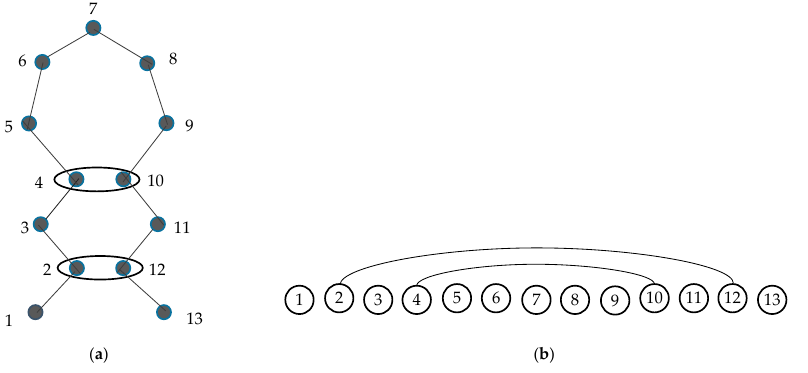
Figure 1. ( a ) Schematic diagram of a protein backbone. Amino acid 2 is in contact with 12 and 4 is in contact with 10 (the distance between two nodes is less than ɛ ). ( b ) The corresponding contact map graph, where two edges connect node 2 with 12 and 4 with 10 [27].